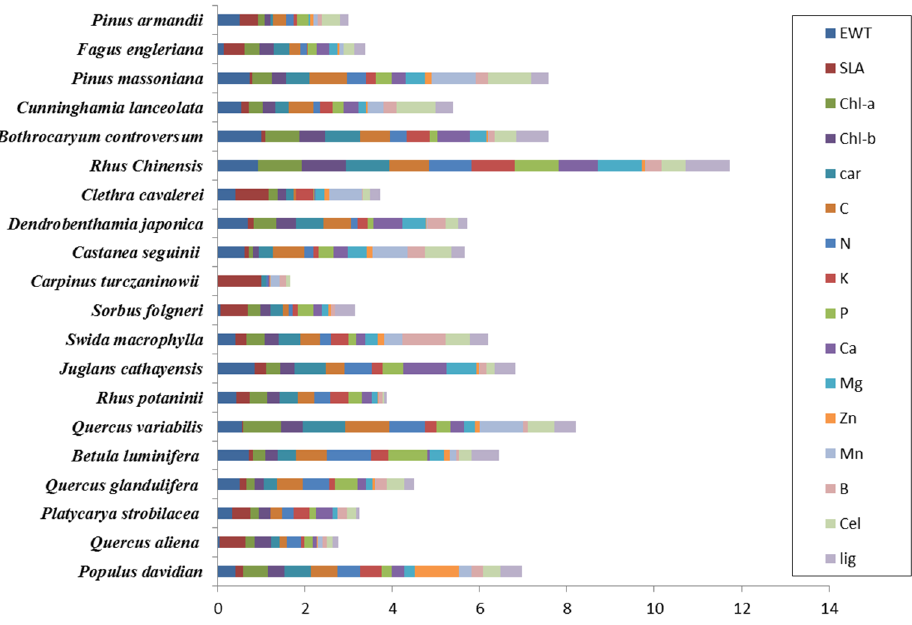
Figure 2. The 16 standardized biochemical components of 20 dominant tree species.